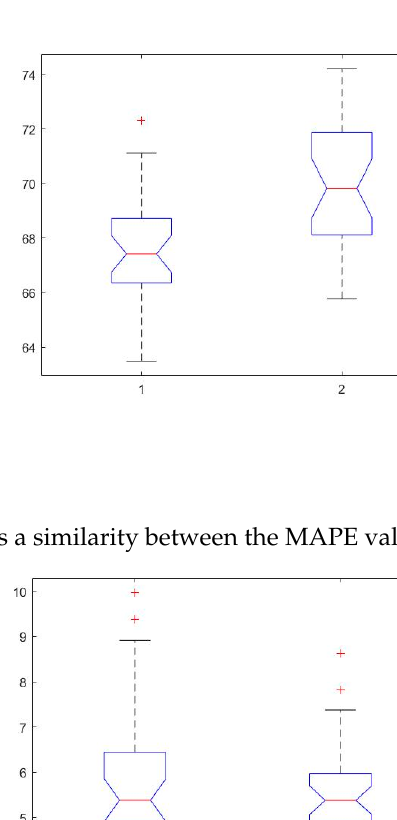
3. POCID indicator. The result indicates a dissimilarity between the POCID values, the